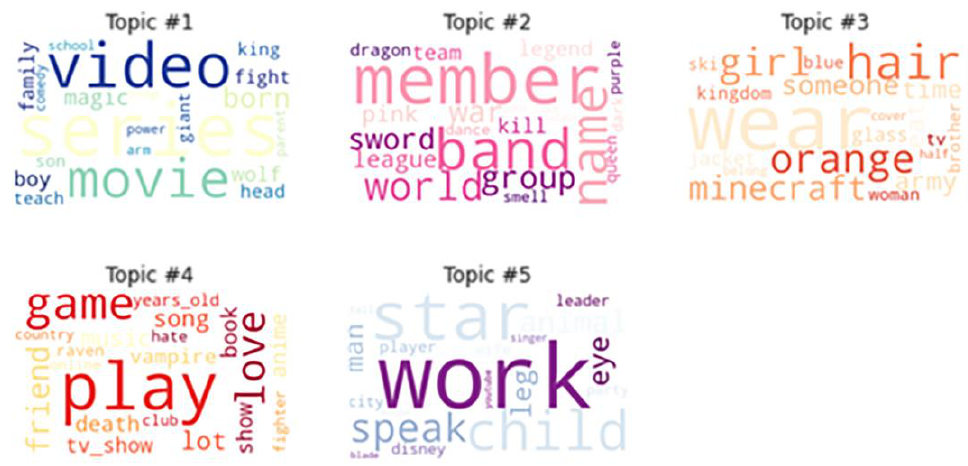
Figure 2. The 20 highest weighted words in each topic created by the LDA model.